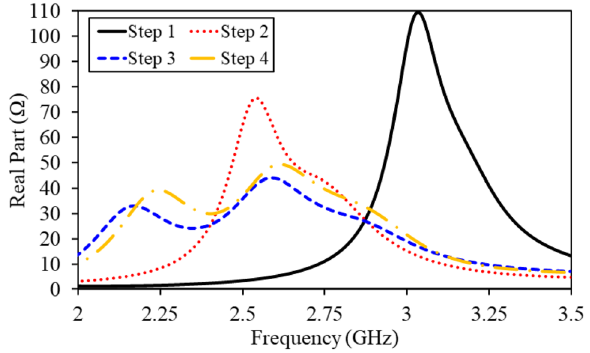
Figure 6. Input impedance (real part) of the antenna in optimization